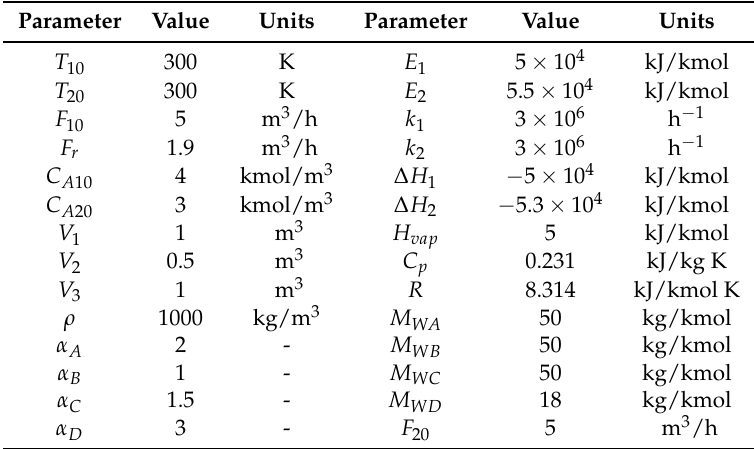
Table 1. Process parameters for the 2 CSTR-flash drum